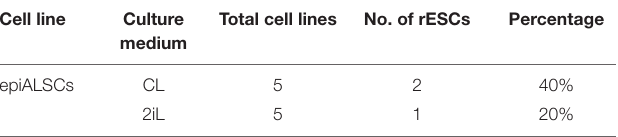
TABLE 4 | Efficiency of rESCs conversed from epiALSCs in CL and 2iL